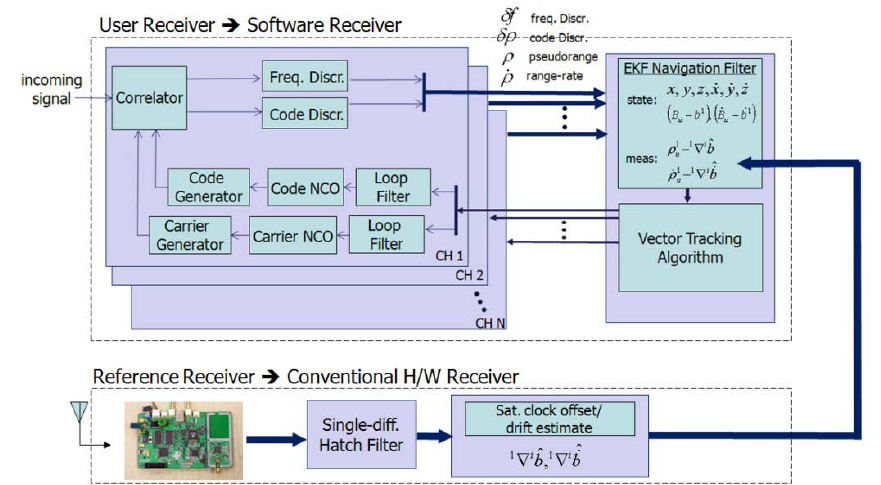
Figure 9. VTL implementation with a new navigation equation